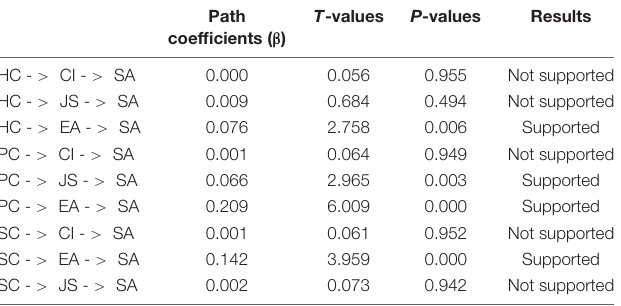
TABLE 4 | Indirect effects